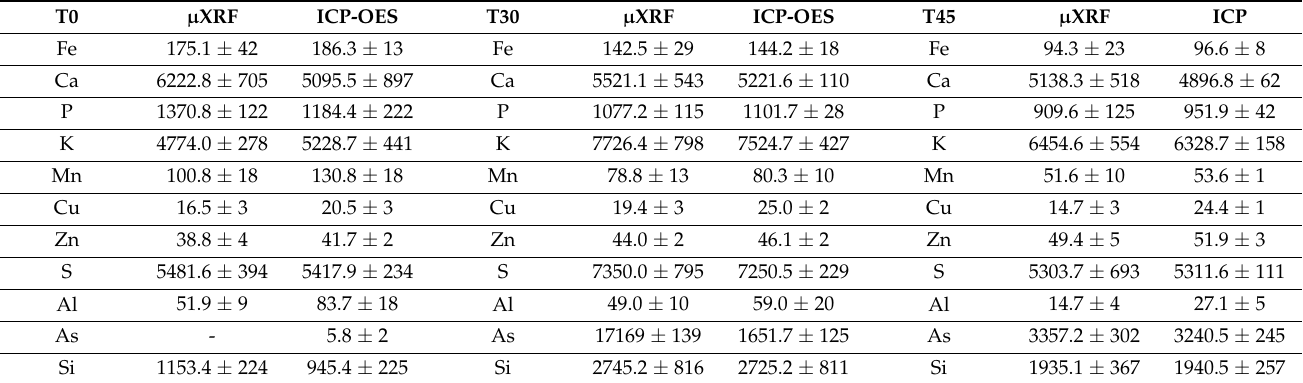
Table 3. Quantitative µ XRF and ICP–OES measurements of powder samples obtained from dried fronds of P. vittata grown in S2 soil for 0, 30 and 45 days. Results in mg/kg are expressed as the mean with its associated confidence